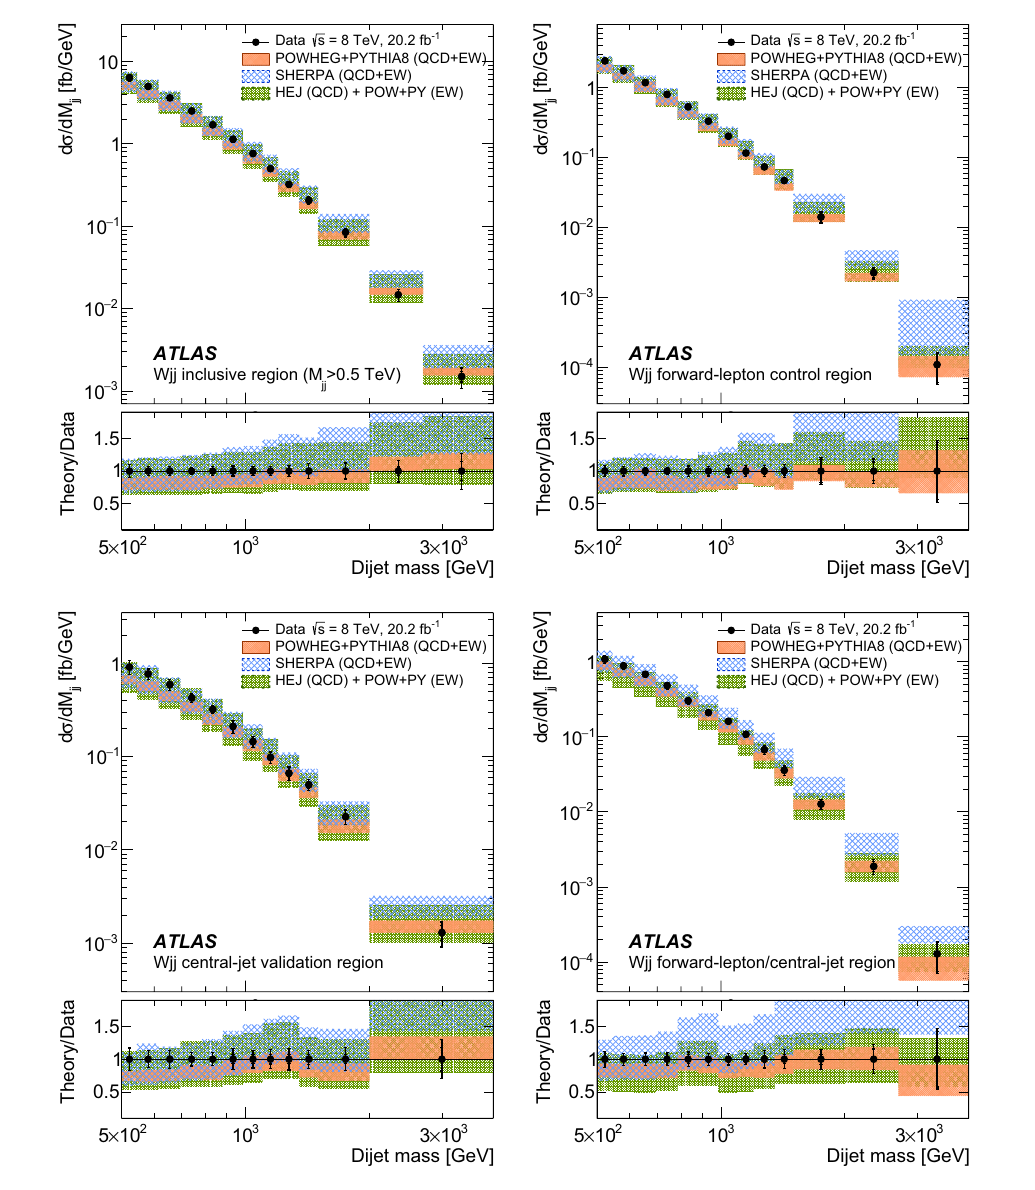
Fig. 30 Unfoldeddifferential W jj productioncrosssectionsasafunc- tion of dijet mass for the inclusive ( top left ), forward-lepton ( top right ), central-jet ( bottom left ), and forward-lepton/central-jet ( bottom right ) fiducial regions, which are enriched in strong W jj production. Both